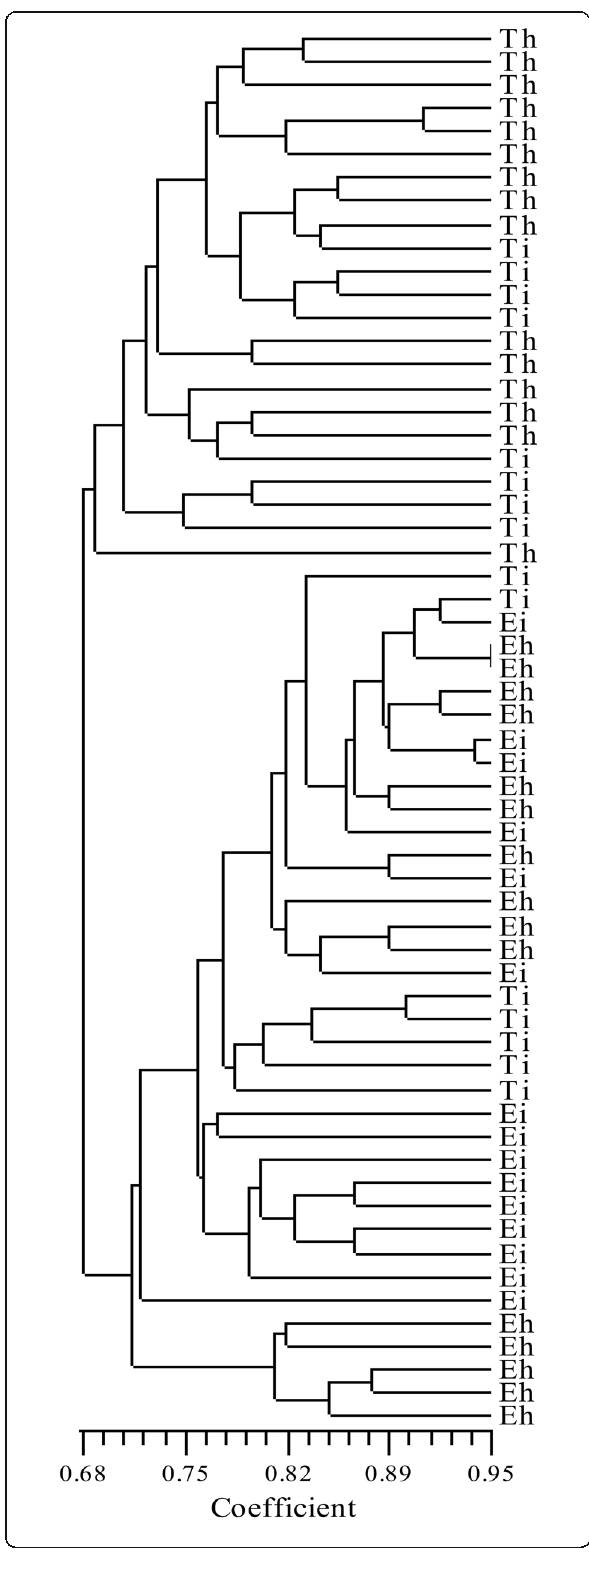
Fig. 2 UPGMA dendrogram (based on combined ISSR and RAPD data) of the 60 healthy (h) and infected (i) B. hyrcana genotypes originating from two populations Tuscatoc (T) and Escolac (E) in the Hyrcanian